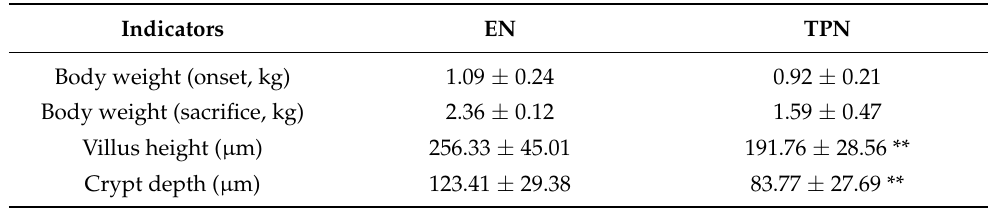
Table 2. General status of TPN piglets. Indicators EN TPN Body weight (onset,